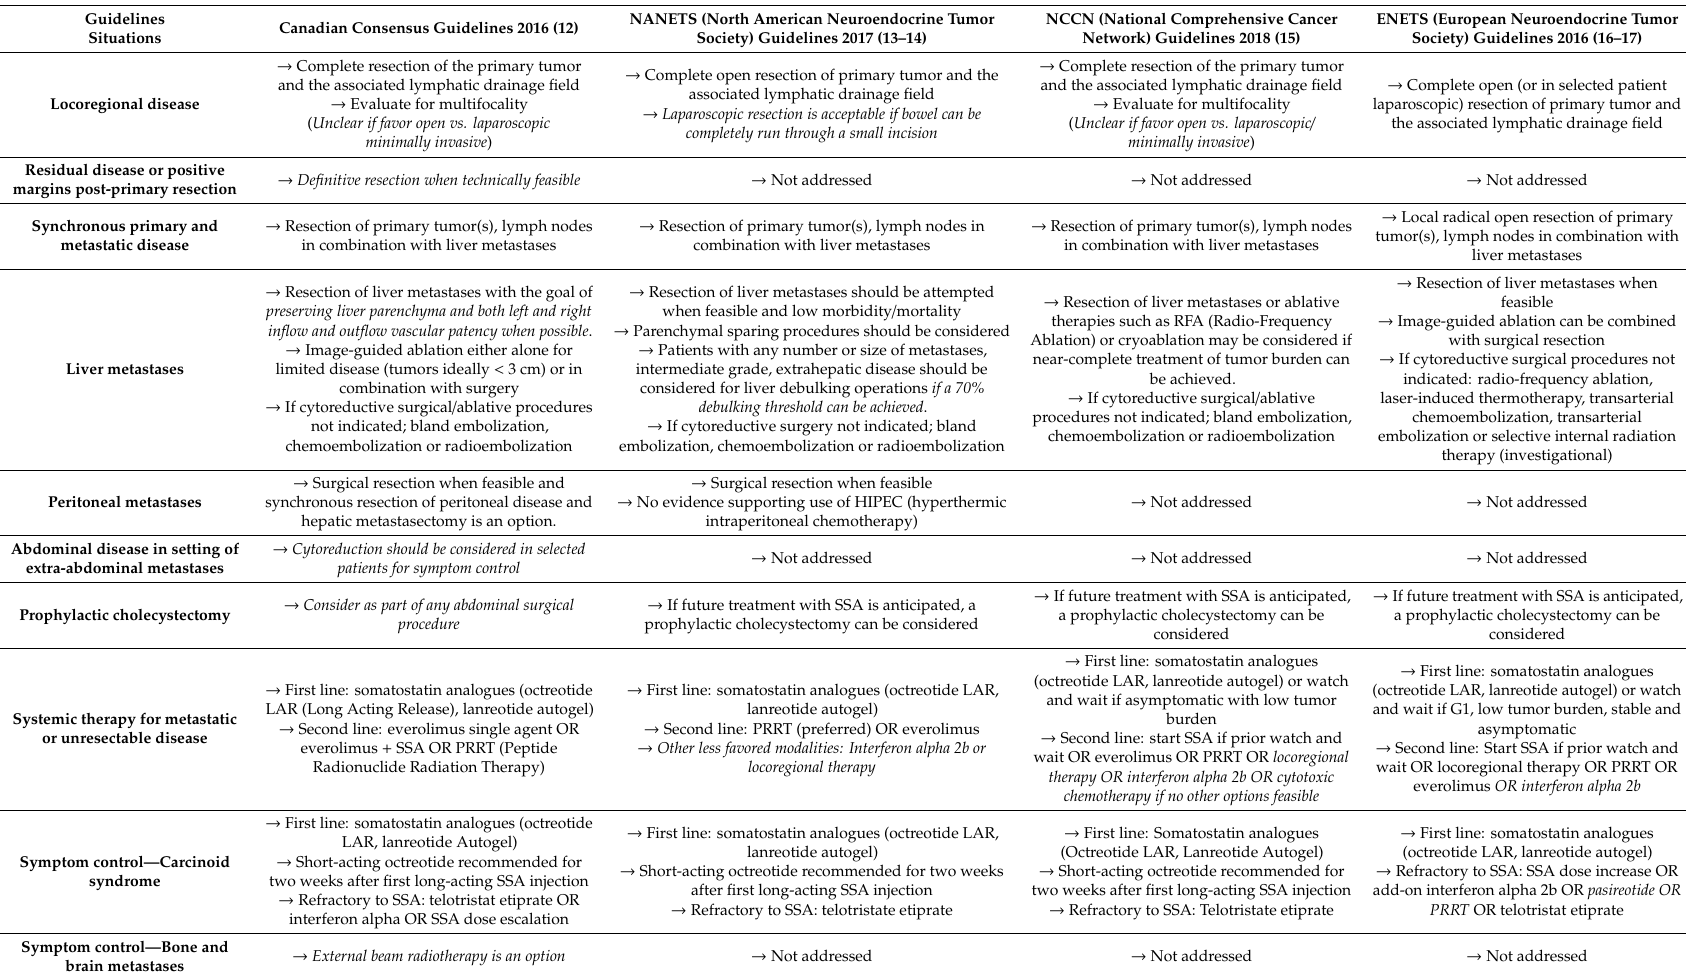
Table 1. Comparison of 4 guidelines on the management of small bowel neuroendocrine